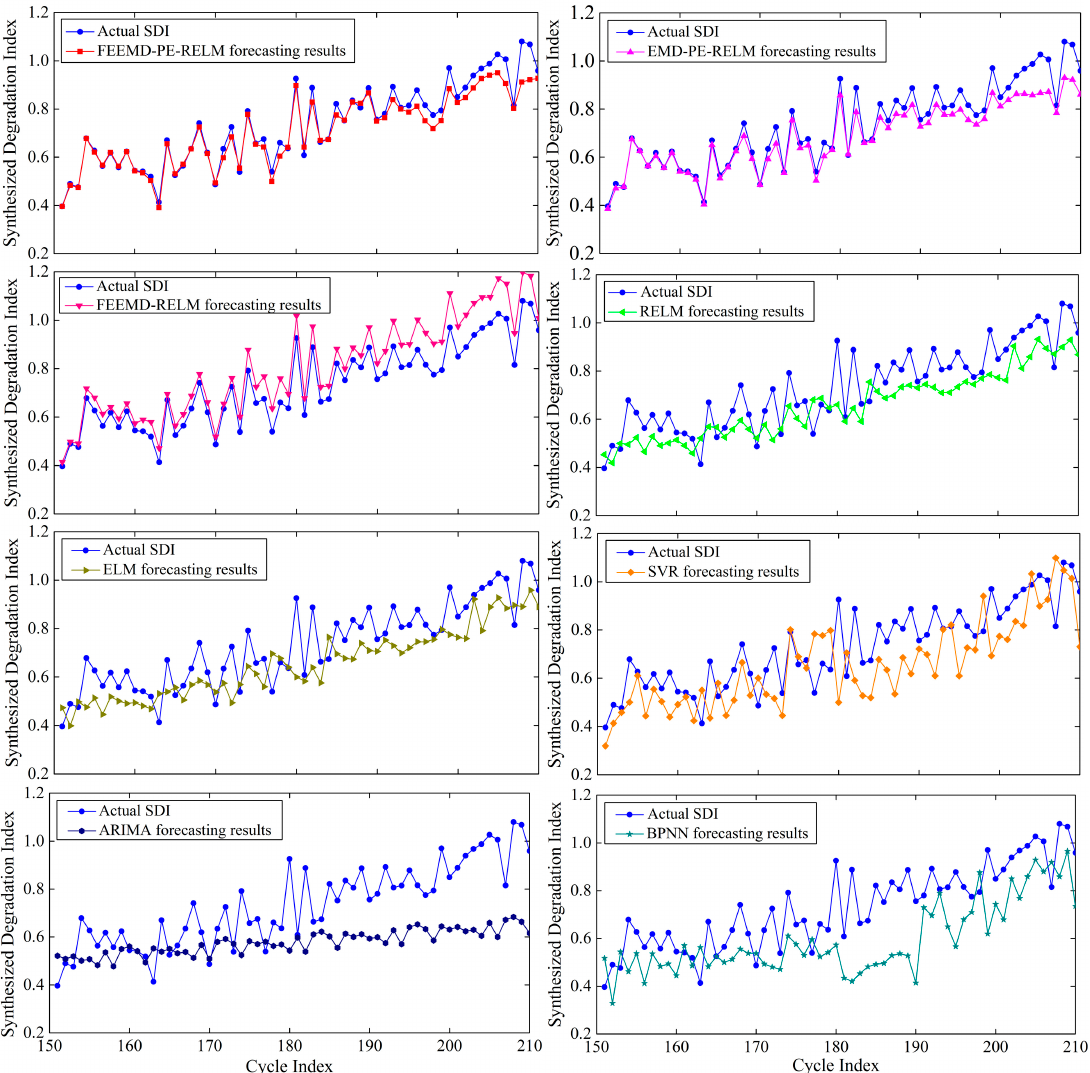
Figure 9. The results of the eight models in the degradation tendency measurement.